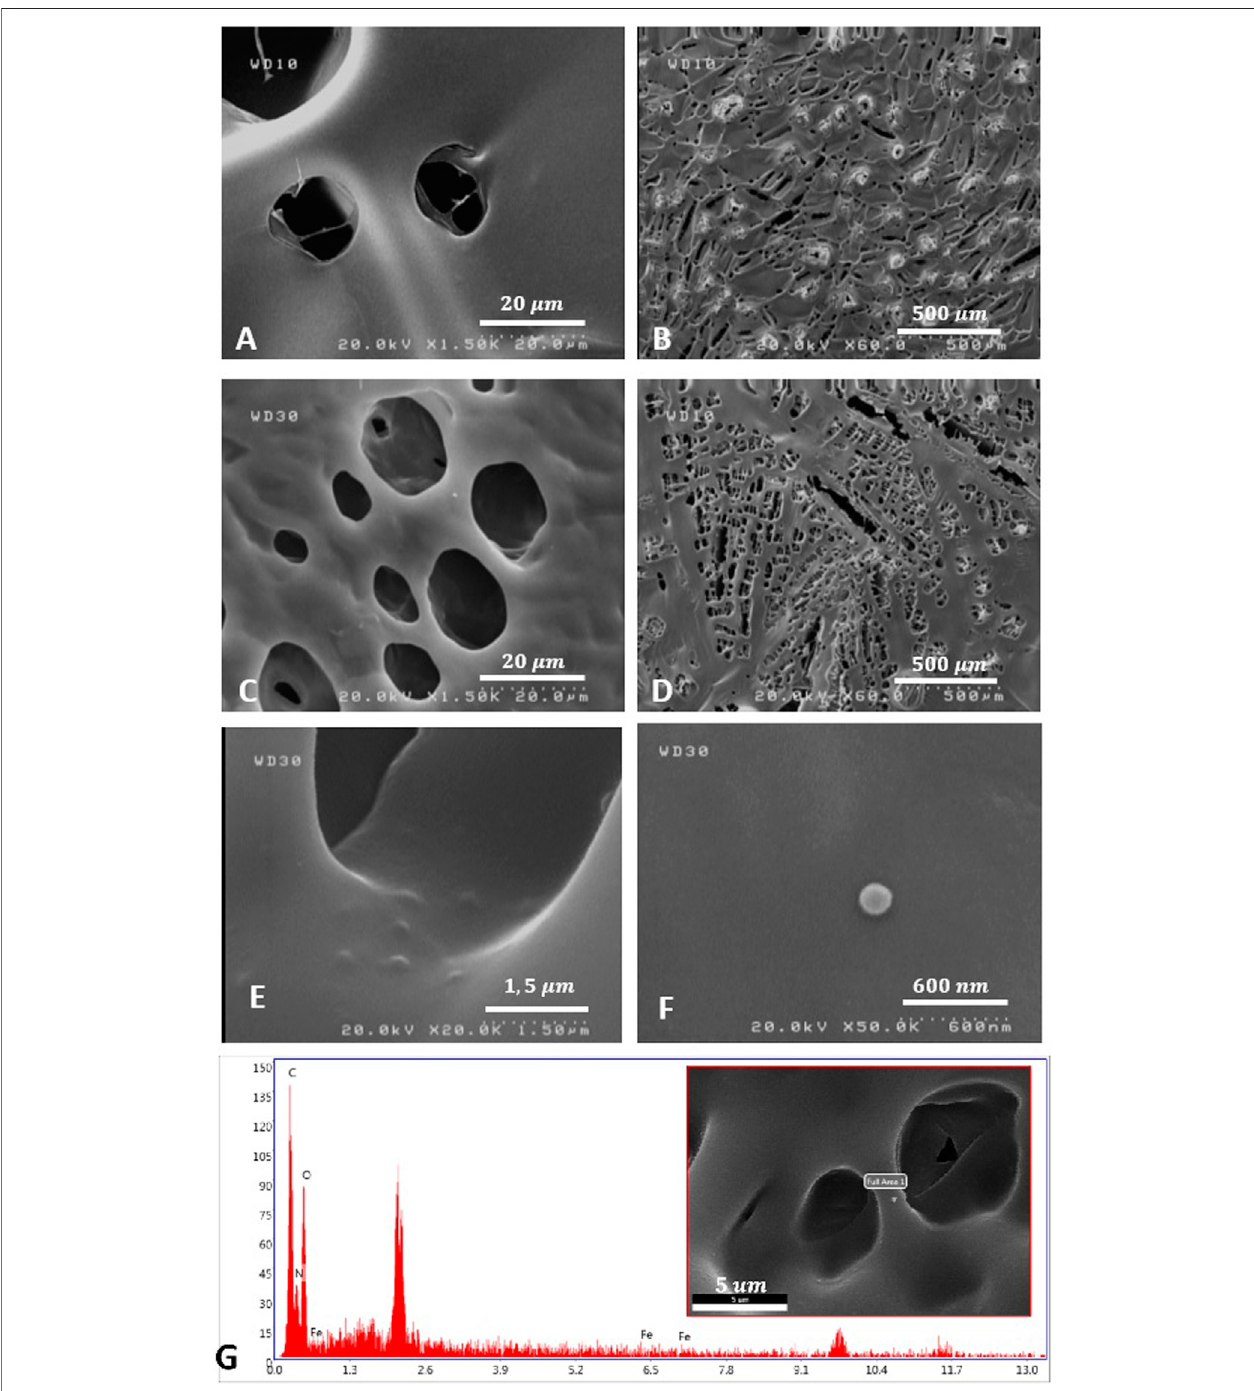
FIGURE 2 | The morphology observation of SFH (A , B) , and SFH/MNP1 (C – F) using FESEM. (G) Material characterization of SFH/MNP1 using Energy Dispersive X-Ray Analysis (EDAX) in the selected area.